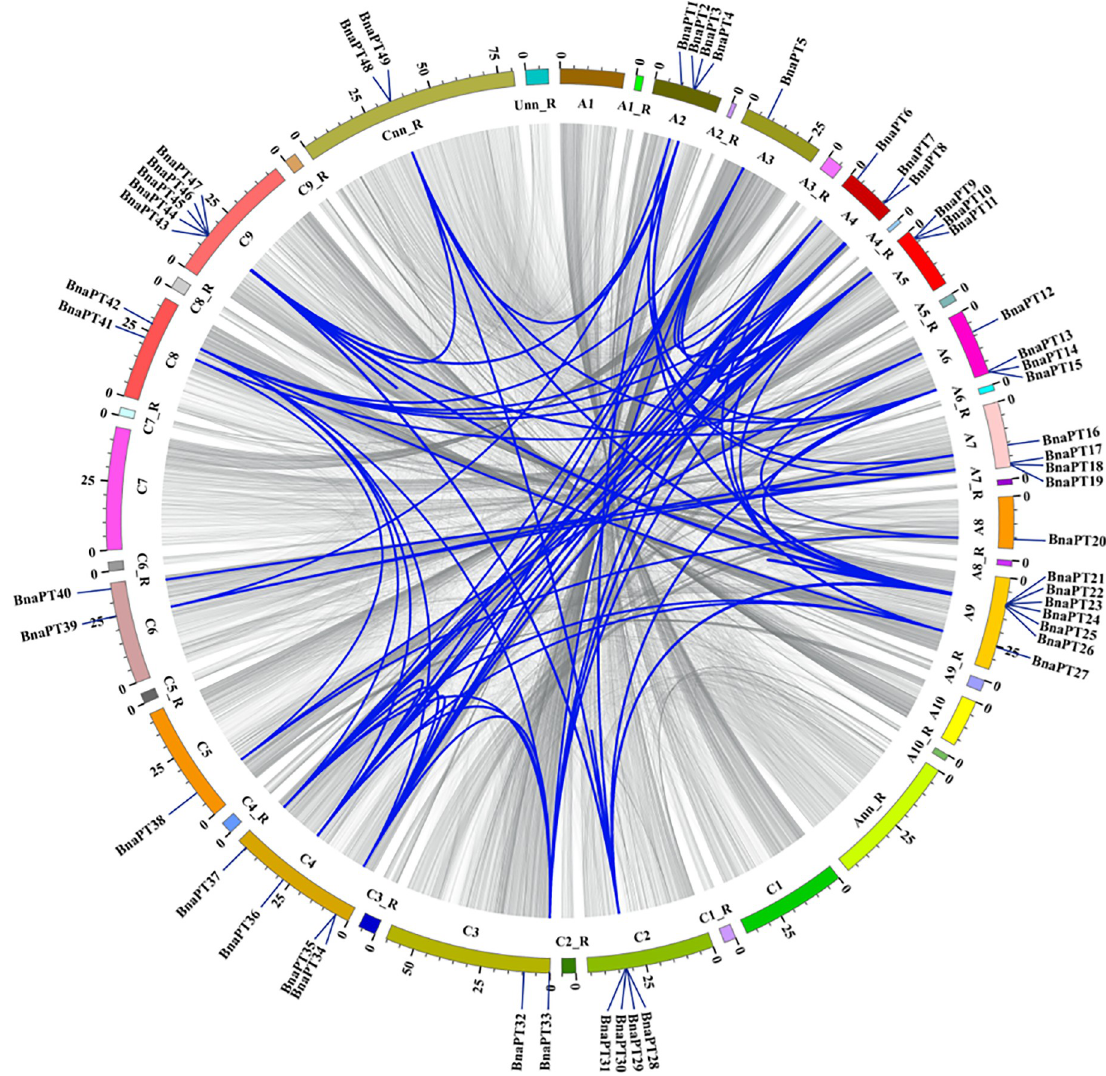
Fig 2. Schematic representations for the chromosomal distribution and interchromosomal relationships of rapeseed PHT1 genes. Gray lines indicate all syntenic blocks in the Brassica napus genome, and the blue lines indicate syntenic PHT1 gene pairs. The chromosome number is indicated at the bottom of each chromosome. R,